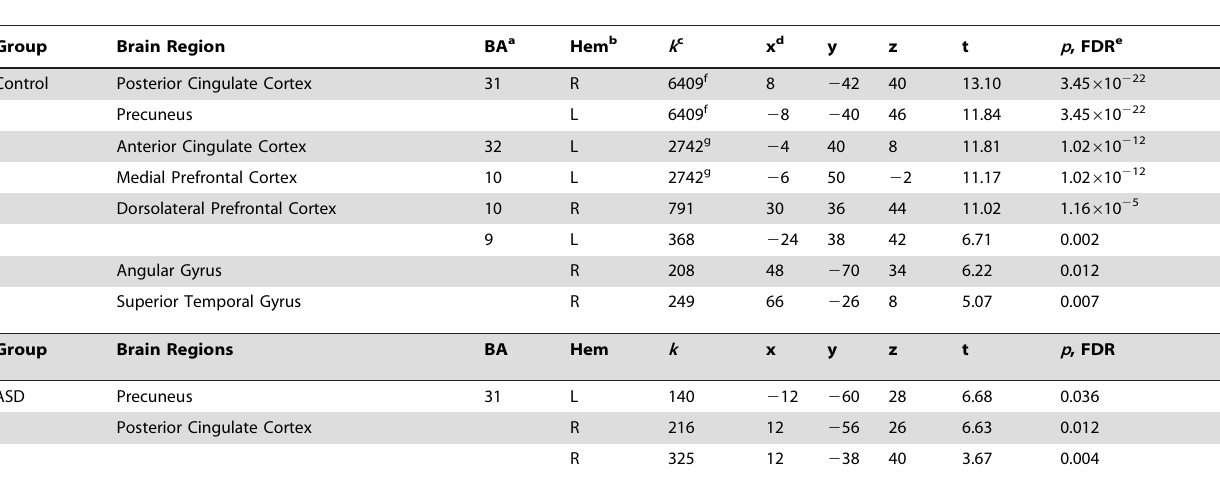
Table 1. Within-group deactivation during all cognitive tasks combined for the ASD (n= 13) and control (n =14) participants (p , 0.001 uncorrected, FDR cluster-corrected).